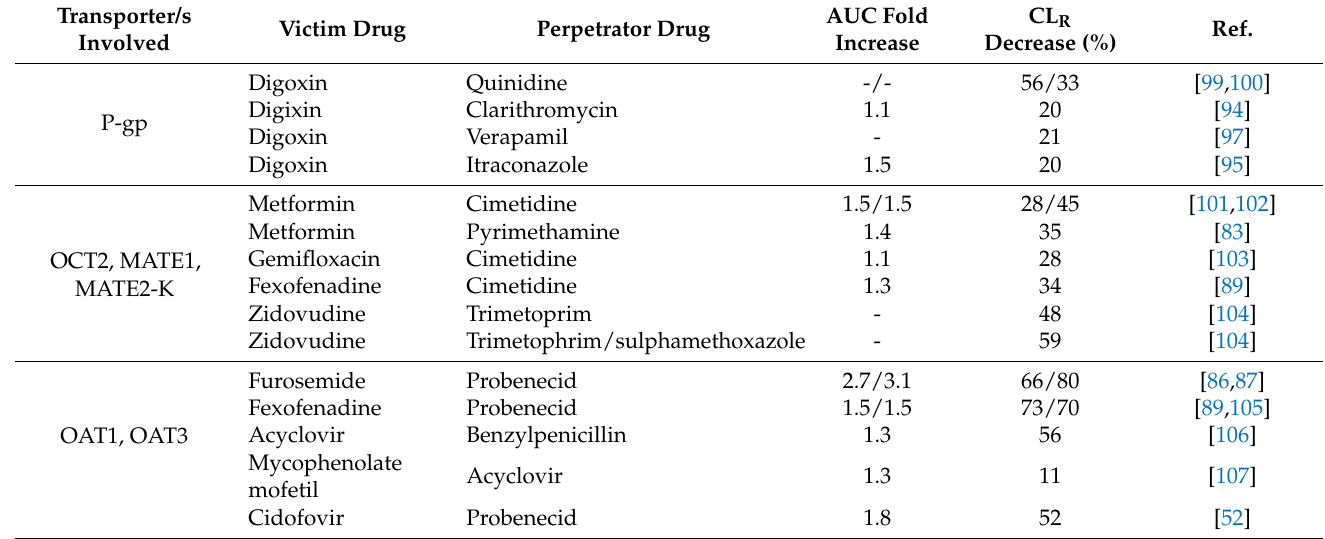
Table 2. DDIs involving renal drug transporters in human